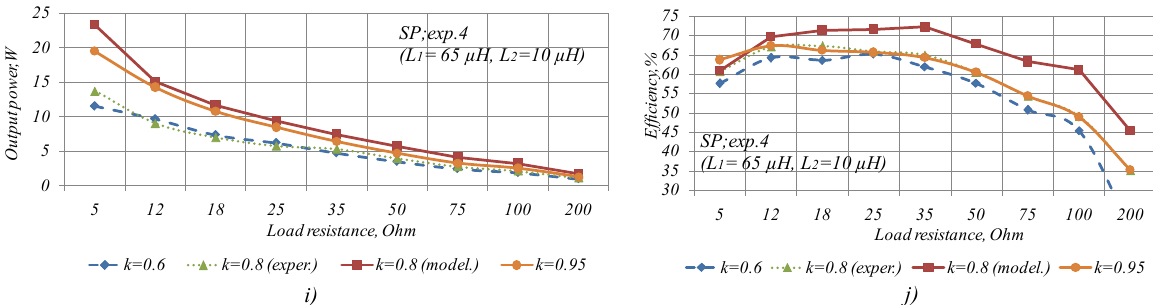
Fig. 3. Experimental and simulation dependences with output power (on the left) and efficiency (on the right) from load resistance ( R load ) at different input voltage levels and at gap between coils δ = 1mm for the investigated compensations of topology.